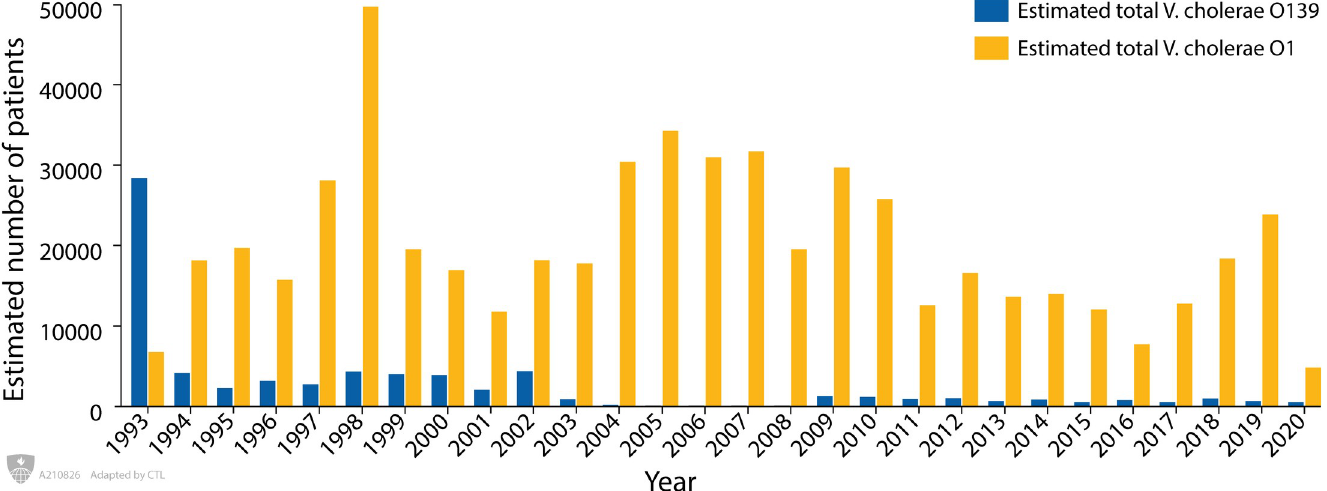
Fig 3. Yearly estimated total Vibrio cholerae O139 and Vibrio cholerae O1 among diarrhoeal patients attended to the Dhaka Hospital of icddr,b; Bangladesh (1993–2020).